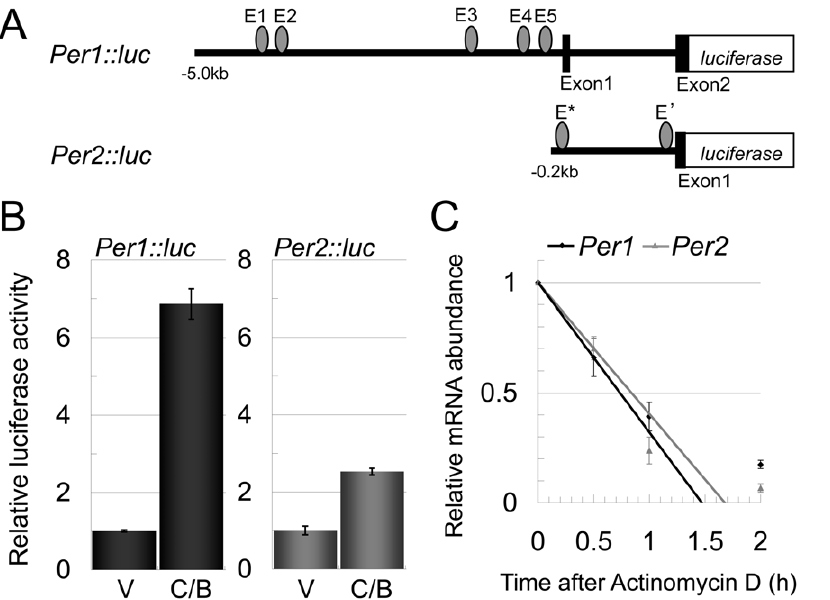
Figure 2. Quantitation and simulation of transcription intensities and degradation velocities of Per1 and Per2 mRNA. (A) Schematic representation of the Per1::luc and Per2::luc reporters. The Per1 promoter driving the luciferase reporter ( Per1::luc ) contains the 6.7-kb region upstream of the translation-initiation codon and includes five E-boxes (CACGTG), and the Per2 promoter driving the luciferase reporter ( Per2::luc ) contains 0.2- kb upstream of the first exon and includes two E-box like elements, E 9 (CACGTT) and E* (CAGGTG). Filled boxes represent exons, and ellipses are E- boxes and E-box like elements. (B) Promoter activities of Per1::luc and Per2::luc . Per1::luc was activated 6.86 6 0.38 times and Per2::luc was activated 2.52 6 0.08 times by co-expression of CLOCK-BMAL1 with respect to their basal promoter activities, respectively. V indicates vector control and C/B indicates CLOCK and BMAL1 co-expression. Error bars indicate SEM determined from independent experiments in triplicate. (C) Initial velocities of Per1 and Per2 mRNA degradation in rat SCN-derived cultured cells. Cellular abundances of Per1 and Per2 mRNA were measured after actinomycin D treatment. The degradation slope of Per1 mRNA was 2 0.68 and the mRNA half-life was 44.1 min, whereas the degradation slope of Per2 mRNA was 2 0.60 and the mRNA half-life was 50.0 min. Error bars indicate SEM determined from independent experiments in quadruplicate, with the exception of the experiment for Per1 1 hour after treatment, which was performed in duplicate. See materials and methods for a detailed description of the experimental procedure.